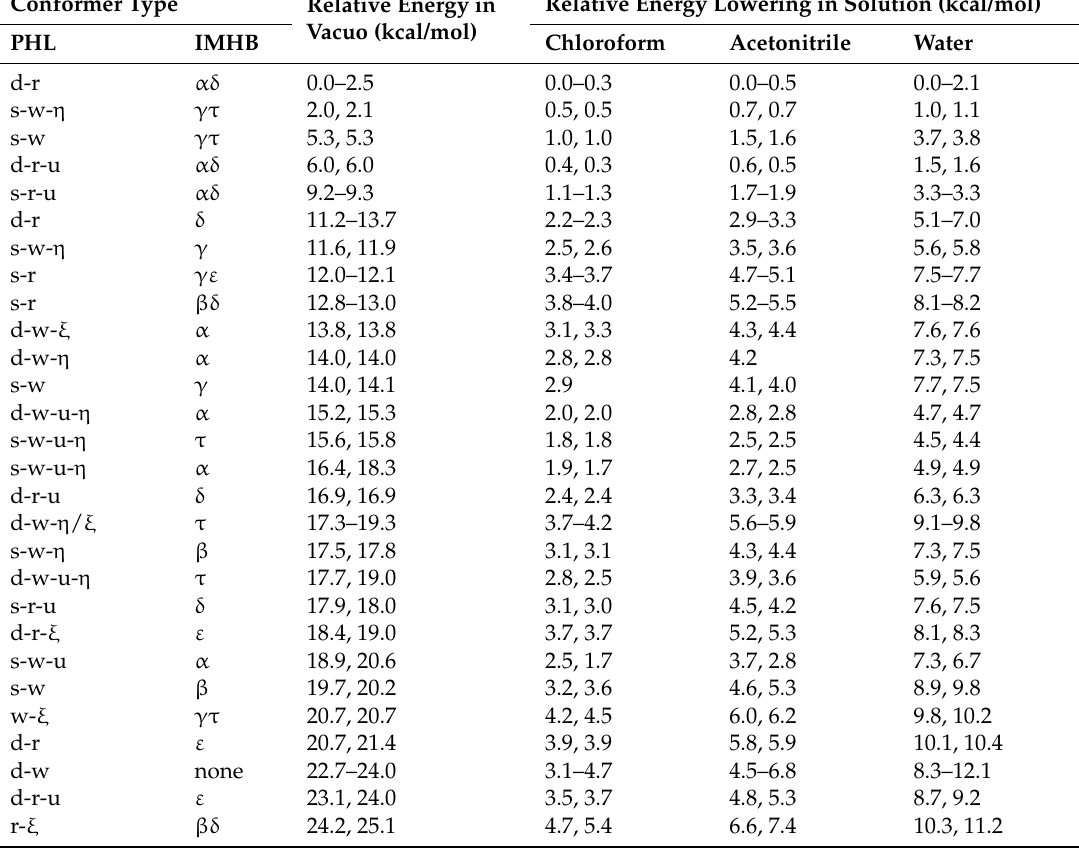
Table 9. Ranges of the relative energy decrease (kcal/mol) in solution with respect to in vacuo. DFT/B3LYP/6-31+G(d,p) results from full optimisation calculations in vacuo and from single point PCM calculations in solution. The types of conformers are characterised by the position of the first IHB and the orientations of the other phenol OH (under the PHL heading) and the types and combinations of IMHB (under the IMHB heading). When only two values are available for a given type, they are both reported, separated by a comma. When the two values of a range are identical, it indicates that at least three coinciding values were